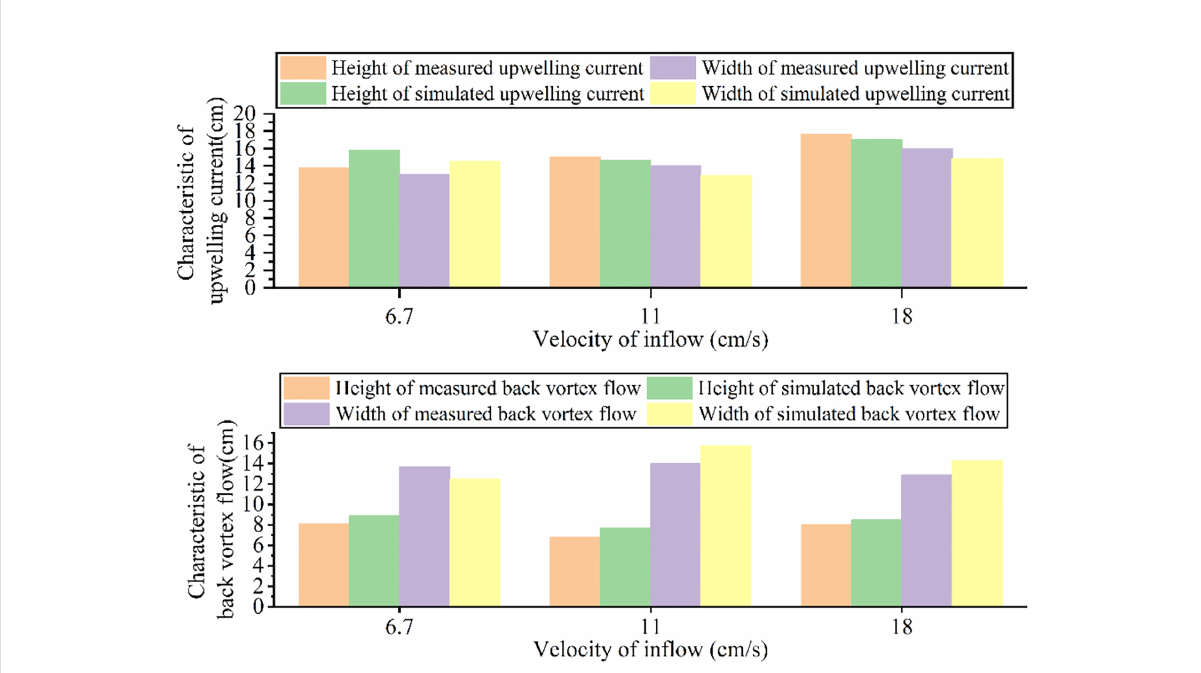
FIGURE 6 Heights and widths of upwelling and the heights and widths of back vortex fl ow of solid cubic AR at three